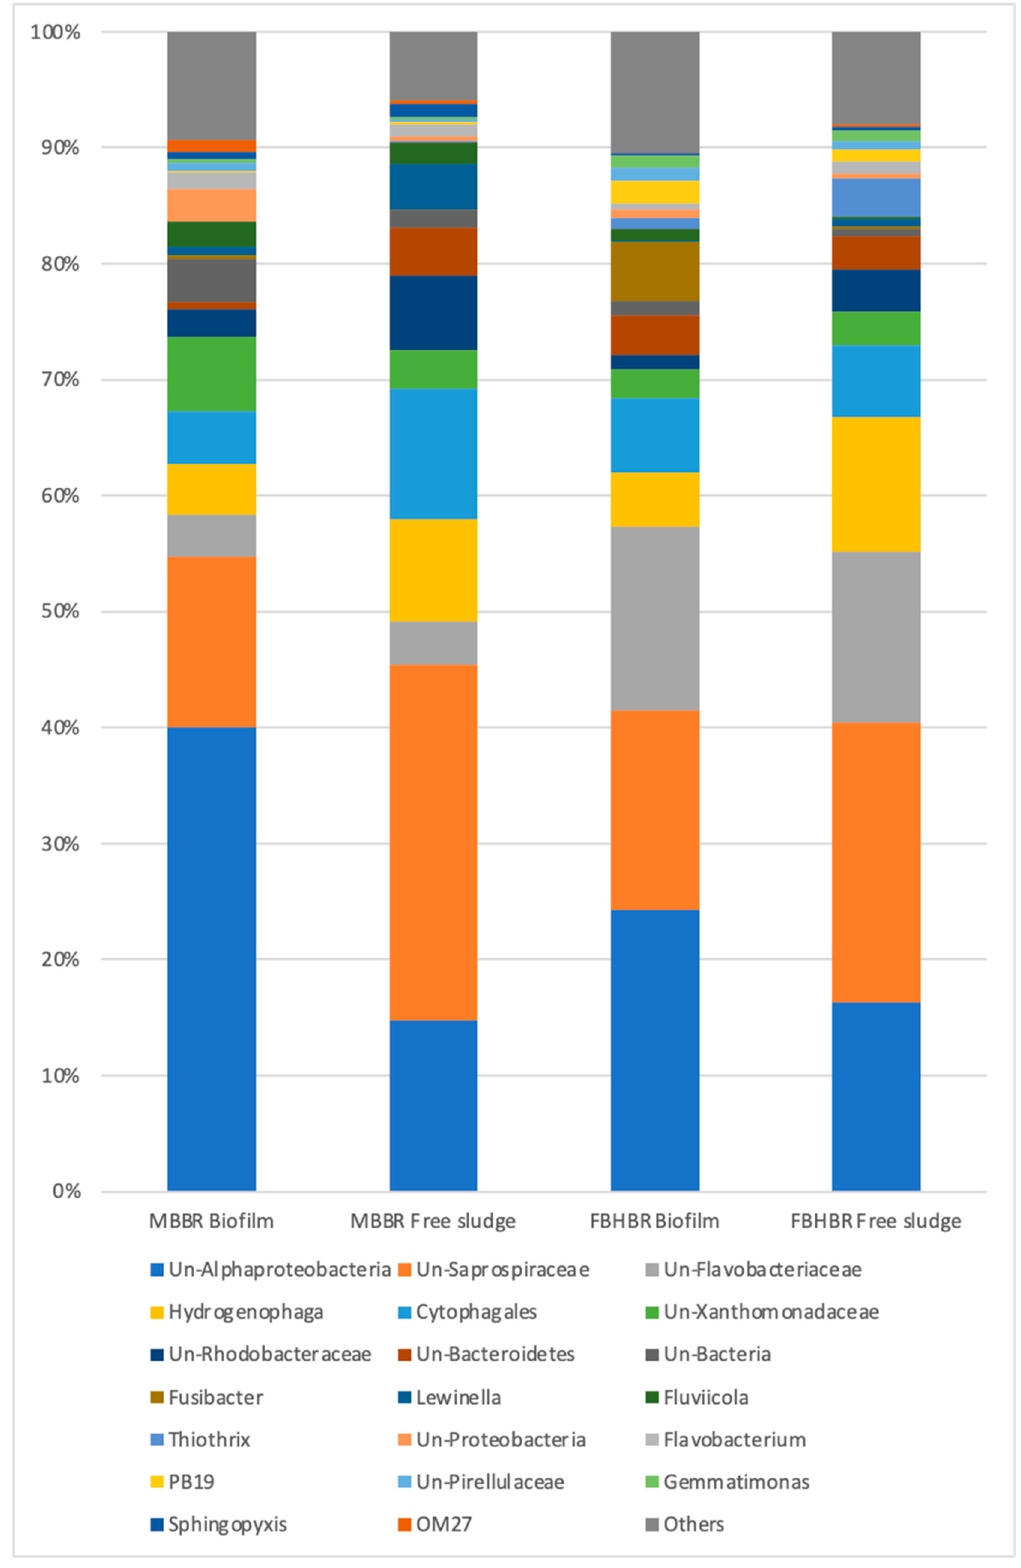
Figure 9. Bacterial assessment at the genus level in the MBBR and the FBHBR at TDS = 20 g·L − 1 (Un stands for unclassified).